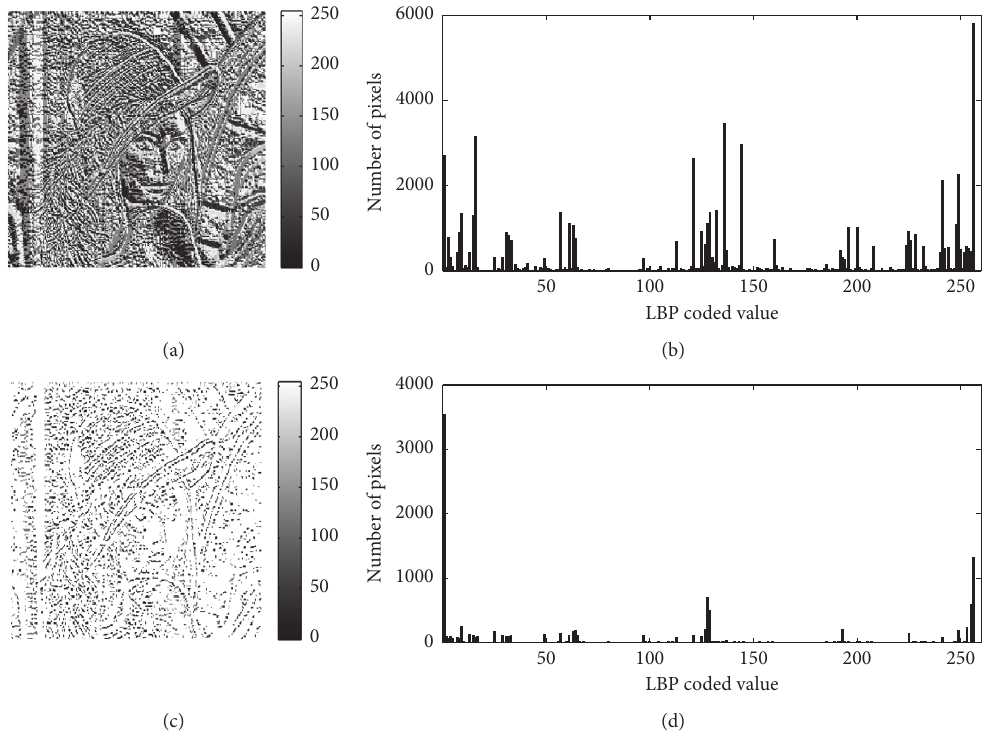
Figure 2: LBP spectrum with different circular domain radius and sampling points. (a) LBP spectrum with [ R, P ] � [ 1 , 8 ] . (b) LBP statistical histogram with [ R,P ] � [ 1 , 8 ] . (c) LBP spectrum with [ R,P ] � [ 2 , 16 ] . (d) LBP statistical histogram with [ R,P ] � [ 2 , 16 ] .